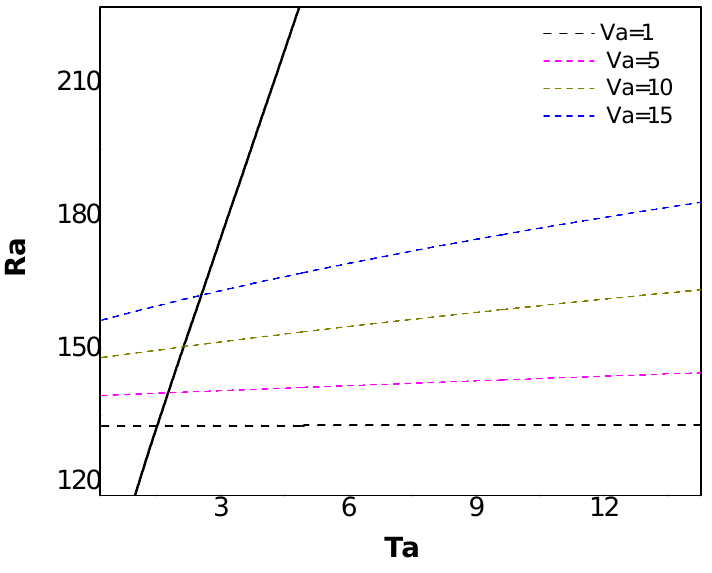
Figure 8. Plots of the critical Ra as the function of Ta for Va = 1, 5, 10,